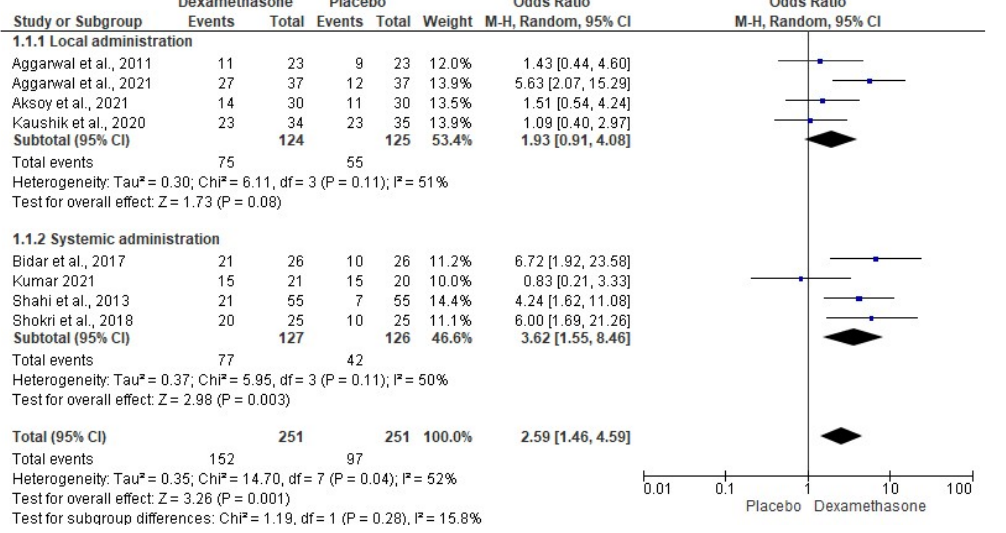
Figure 3. Pooled analysis of the anesthetic success rate ( p < 0.05) [8,9,11,14,16,17,20,21]. Moreover, no study reported that dexamethasone improved the depth of anesthesia, whereas one dexamethasone clinical trial [11] found an increased duration of anesthesia. The pooled evaluation of pain intensity was carried out using the data of three clinical trials ( n = 302) [15,22,23]. The pre-endodontic pain scores were similar between the dexamethasone group and the control group. In this sense, patients who received dexamethasone had lower pain intensity at 6 ( p < 0.001), 12 ( p < 0.0001), and 24 ( p < 0.0008) postoperative hours when compared to those who were given local anesthetics (Figure 4).